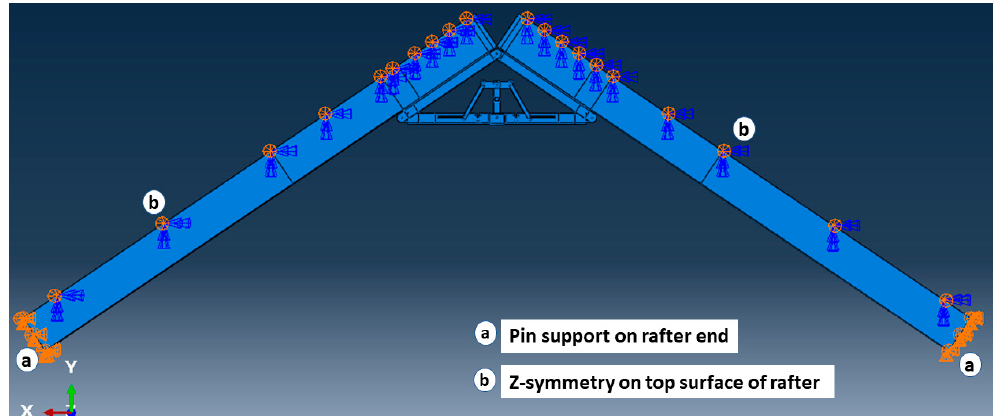
Figure 21. 3D assembly model and boundary condition.